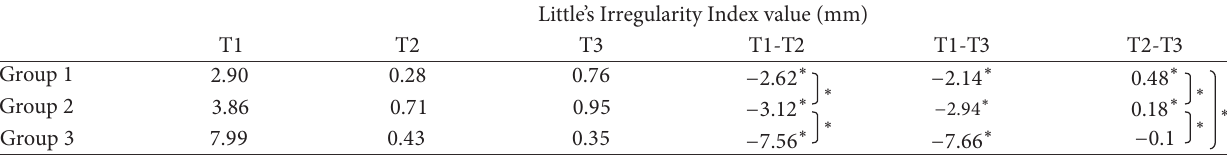
Figure 3: Mean values of Little’s Irregularity Index and their changes from beginning (T1) via leveling (T2) until retention stage (T3) of an orthodontic treatment, ∗ 𝑝 < 0.05